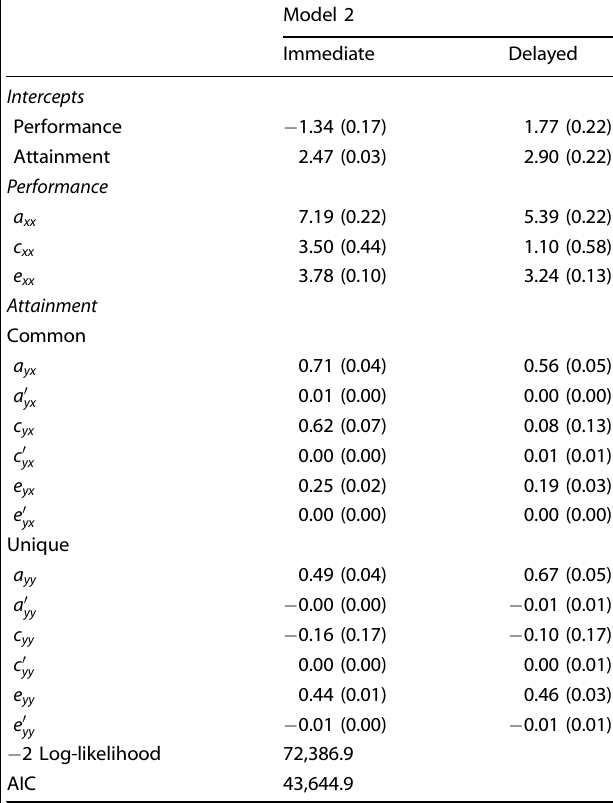
Table 2. Bivariate Cholesky ACE-decomposition of educational performance and attainment split by timing of tracking and moderated by educational performance ( N =